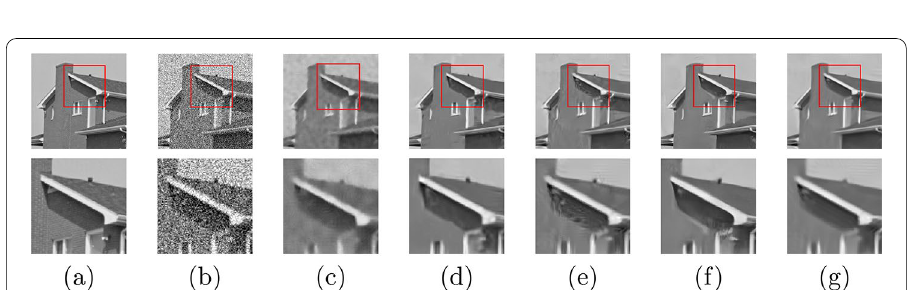
Fig. 9 Denoising results of natural image ( house ) with the noise variance σ = 50 [top] and zoom-in image [bottom]. From the left ( a ) to right ( g ) are: the original image, the noisy image, the results obtained by NLM, BM3D, OGLR, ADnet and the proposed method respectively